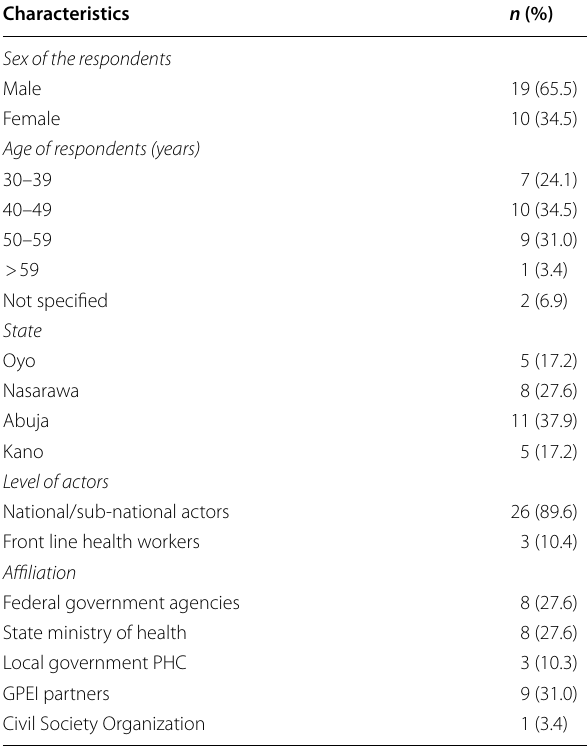
Table 1 Sociodemographic characteristics of sampled